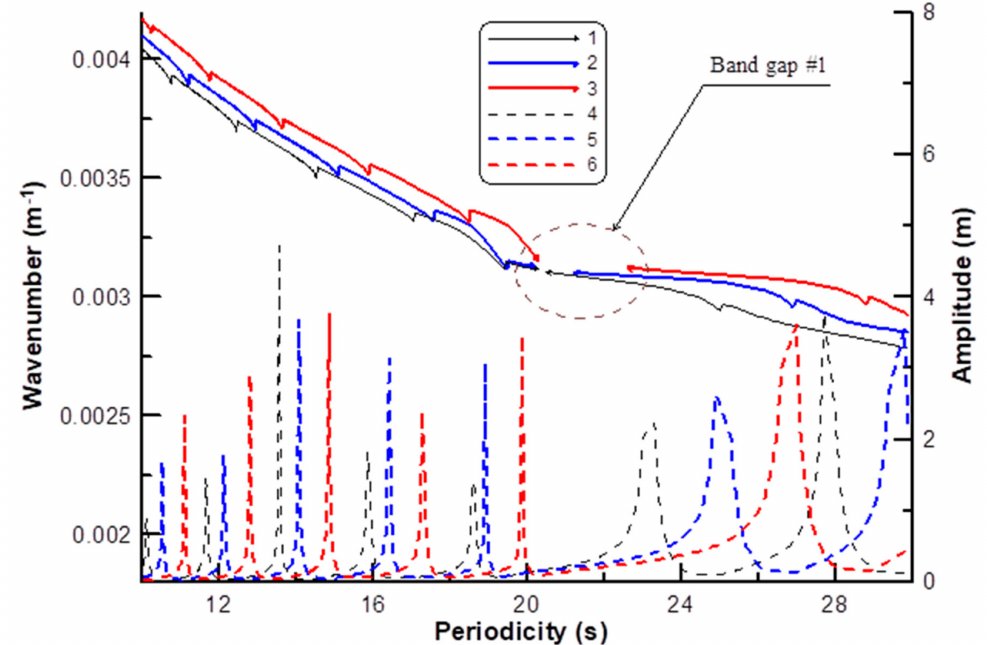
Figure 3. The dispersion spectra (curves 1–3) and the amplitude spectra (curves 4–6). The ice shelf length is 16 km, the width is 0.8 km, and the thickness is 100 m. Curves 1—3 are the dispersion spectra obtained for the crevasse-ridden ice shelf: 1— d cr = 10 m; 2— d cr = 20 m; 3— d cr = 30 m. Curves 4–6 are the amplitude spectra obtained for the crevasse-ridden ice shelf: 4— d cr = 10 m; 5— d cr = 20 m; 6— d cr = 30 m where d cr is the crevasses depth. Spatial periodicity of the crevasses is equal to 1 km. Young’s modulus = 9 GPa, Poisson’s ratio ν = 0.33